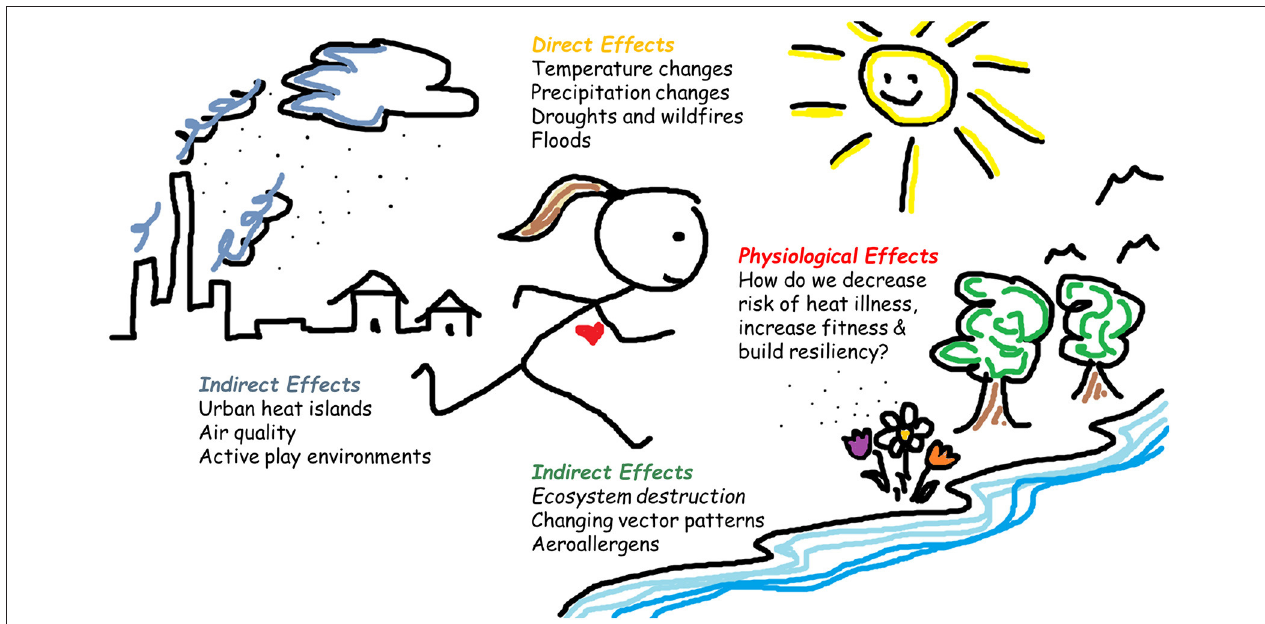
FIGURE 1 | Effects of climate change on the health of exercising children. Climate change will require human adaptation to its direct (e.g., temperature changes, floods) and indirect interconnected effects (e.g., air pollution, changing disease vector patterns), especially in children, who are considered a vulnerable population and have not been the focus of recent scientific research or policy making to this point, despite clear evidence that children require special focus to reduce health risk. The heading “Physiological effects” refers to both positive and negative adaptations to climate change, from exposure to environmental factors like air pollution and